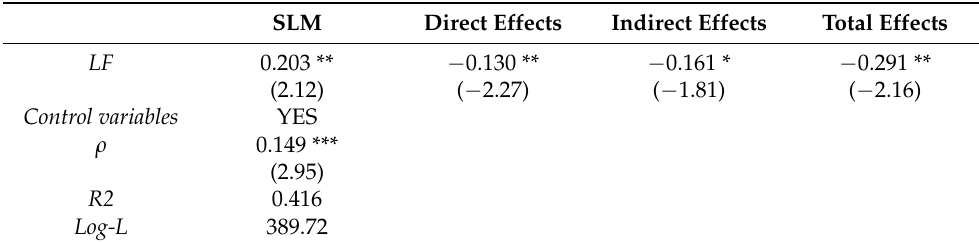
Table 8. Robustness test based on spatial distance weight